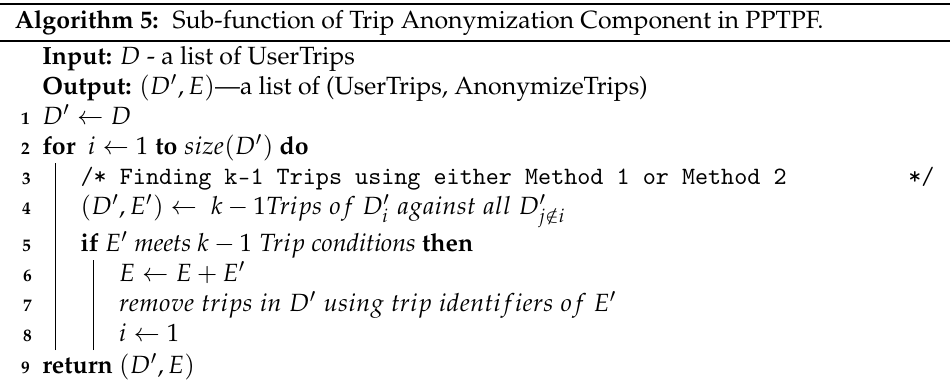
Algorithm 5: Sub-function of Trip Anonymization Component in